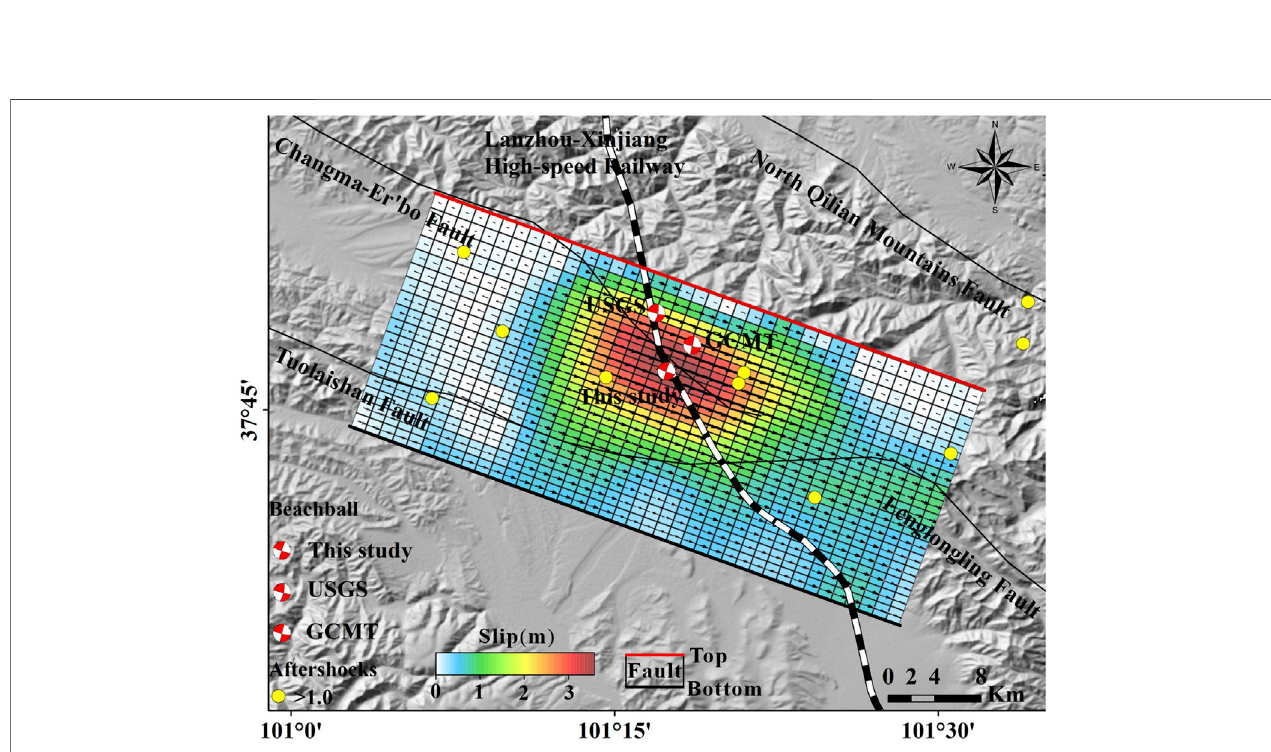
FIGURE7| Distribution slipinversion resultsofthe2022Menyuanearthquake,including observed,modeled,andresidualdata. (A) Sentinel-1Ainascendingtrack (T128). (B) Sentinel-1A in descending track (T33).